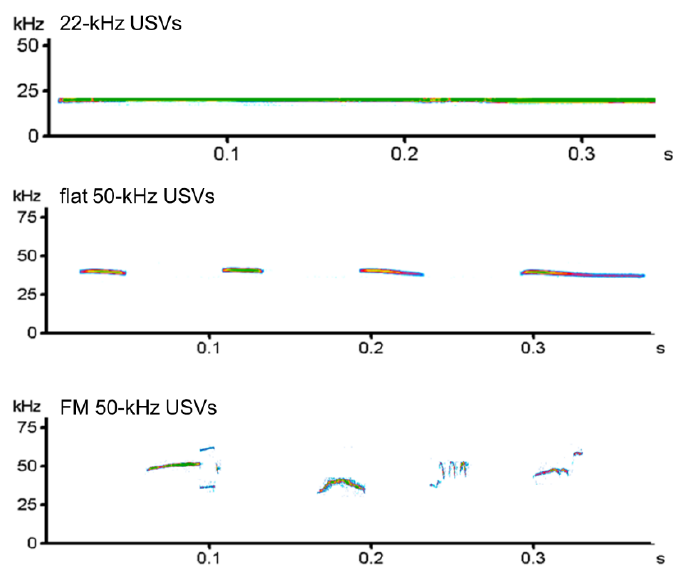
Figure 2. Example of spectrograms of 22-kHz and 50-kHz ultrasonic vocalizations recorded in the present study. The vocalizations reported in the figure are independent calls emitted by different rats. FM = frequency-modulated; USVs = ultrasonic vocalizations.